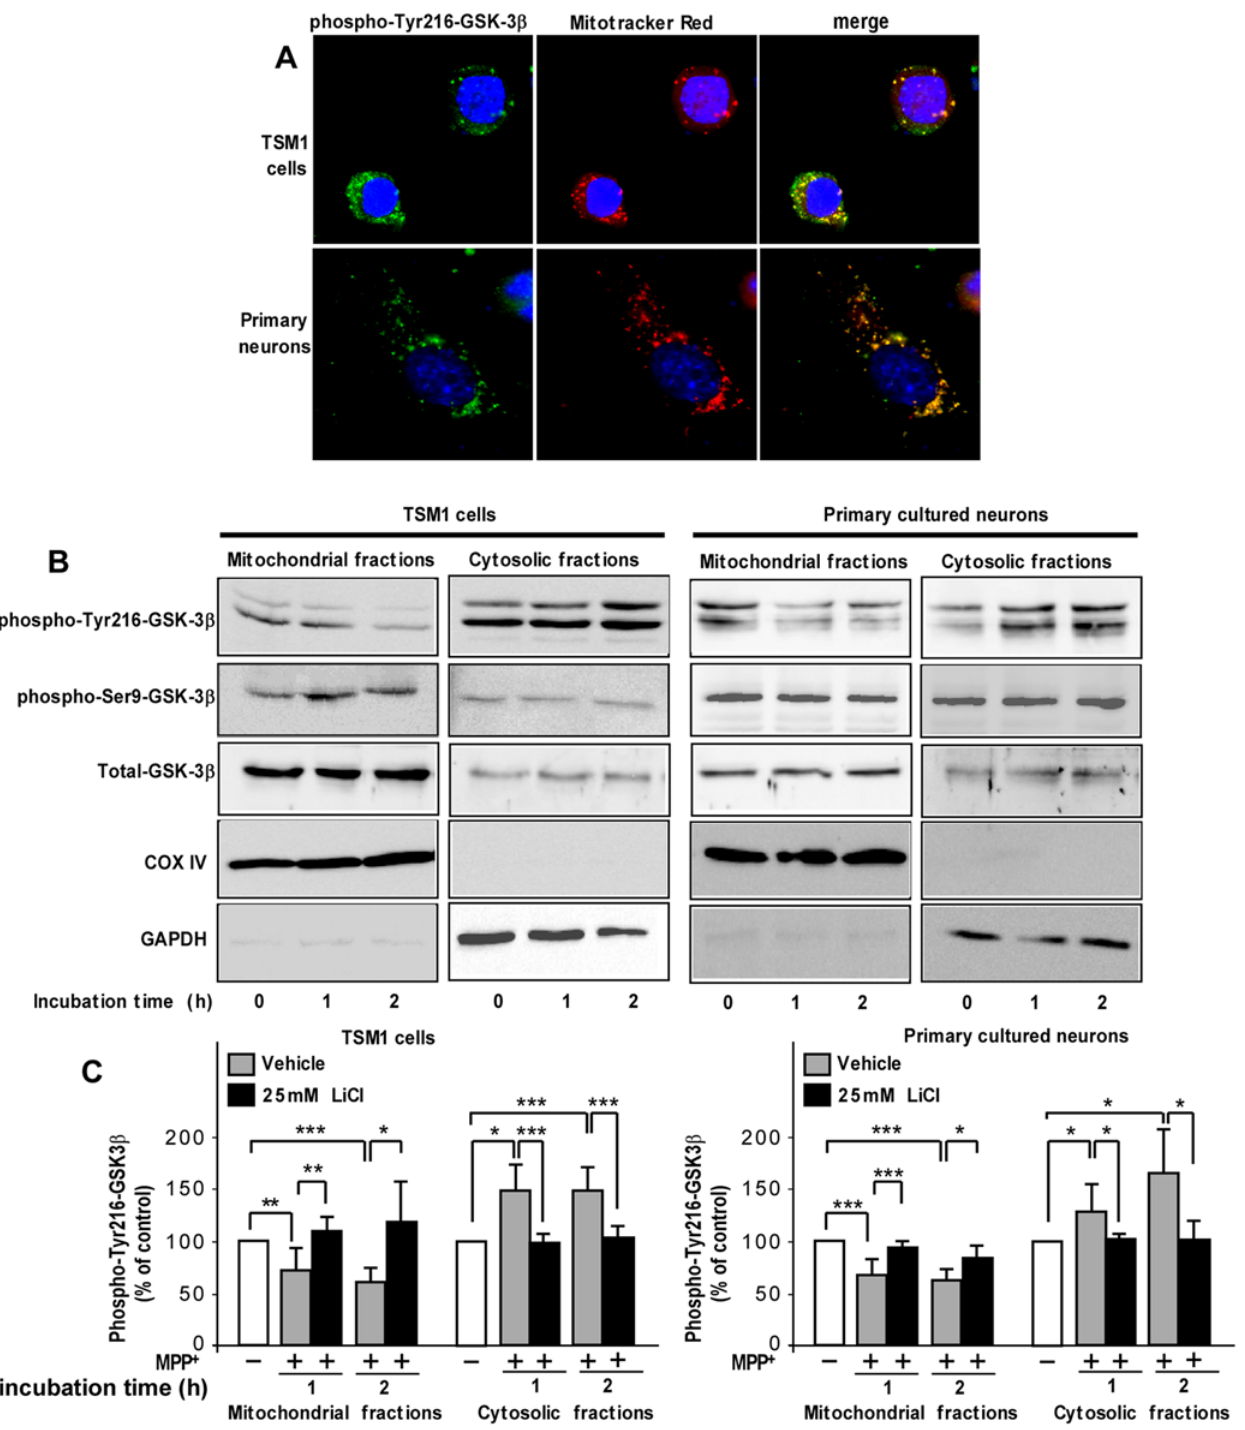
Figure 4. GSK-3 b partially localized within mitochondria and MPP + differentially affected phospho-Tyr216-GSK-3 b in mitochondrial and cytosolic fractions. (A) Fluorescence microscopy pictures of TSM1 and primary cultures of neurons loaded with 100 nM MitoTracker TM ( red ), then fixed, permeabilized and stained for phospho-Tyr216-GSK-3 b ( green ) and nuclei (DAPI, blue ). Magnification 6 25. (B, C) TSM1 neurons ( left ) and cultured primary neurons ( right ) were treated with 400 m M MPP + for 1 and 2 h then submitted to subcellular fractionation in order to separate mitochondrial and cytosolic fractions, as described in Materials and Methods. Both fractions were analyzed for phospho-Tyr216-GSK-3 b , phospho- Ser9-GSK-3 b , total GSK-3 b , COXIV and GAPDH contents by Western blotting (B). (C) Densitometry analyses of four to eight independent experiments were carried out to quantify the phospho-Tyr216-GSK-3 b content in mitochondrial and cytosolic cellular fractions of vehicle- and LiCl-pretreated TSM1 ( left ) and primary cultured neurons ( right ). Data are expressed as percentage of the untreated samples. Statistical analysis was done using Student t -test (* p , 0.05, ** p , 0.01, *** p , 0.005 versus untreated sample).